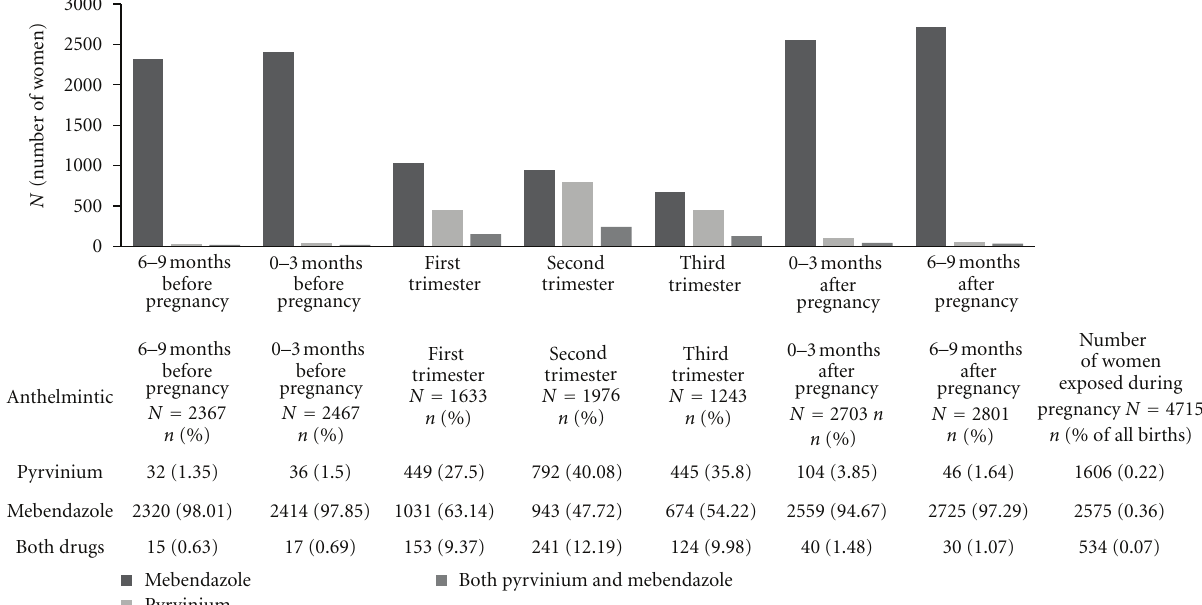
Figure 1: The maternal exposure to pyrvinium, mebendazole, and both drugs before, during, and after pregnancy, expressed by seven three-month time frames. For a better overview the data is shown in tables and